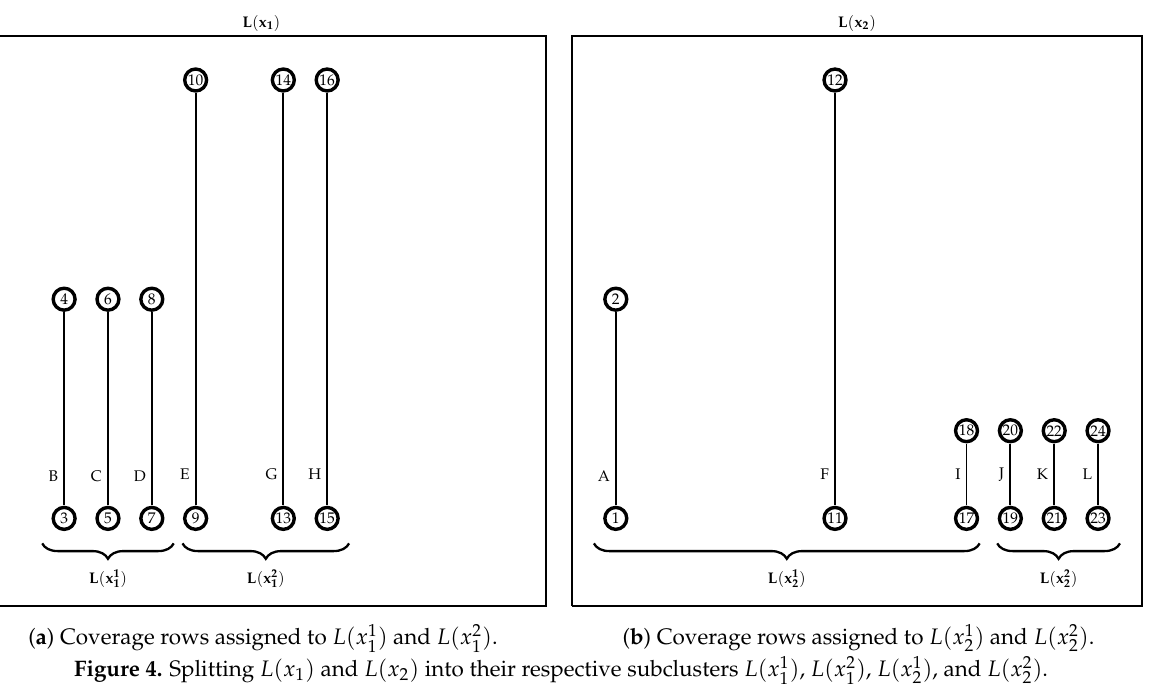
( a ) Coverage rows assigned to L ( x 1 Figure 4. Splitting L ( x 1 ) and L ( x 2 ) into their respective subclusters L ( x 1